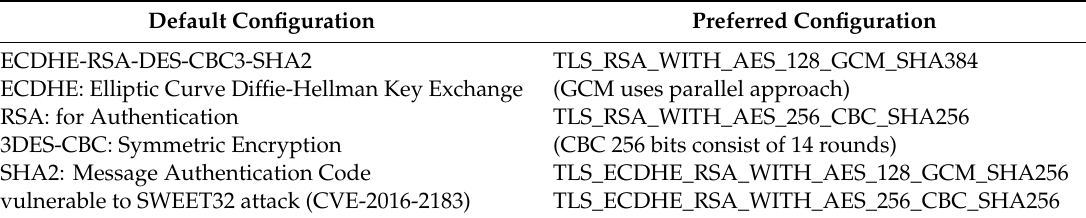
Table 3. Default configuration of transport layer security (TLS) in Onion